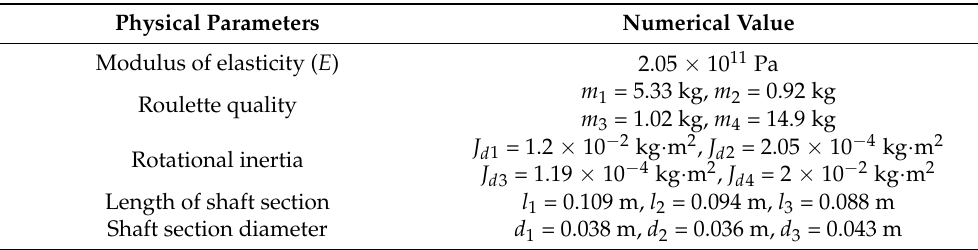
Table 1. Simplified disk-shaft model parameters for a supercharger rotor.